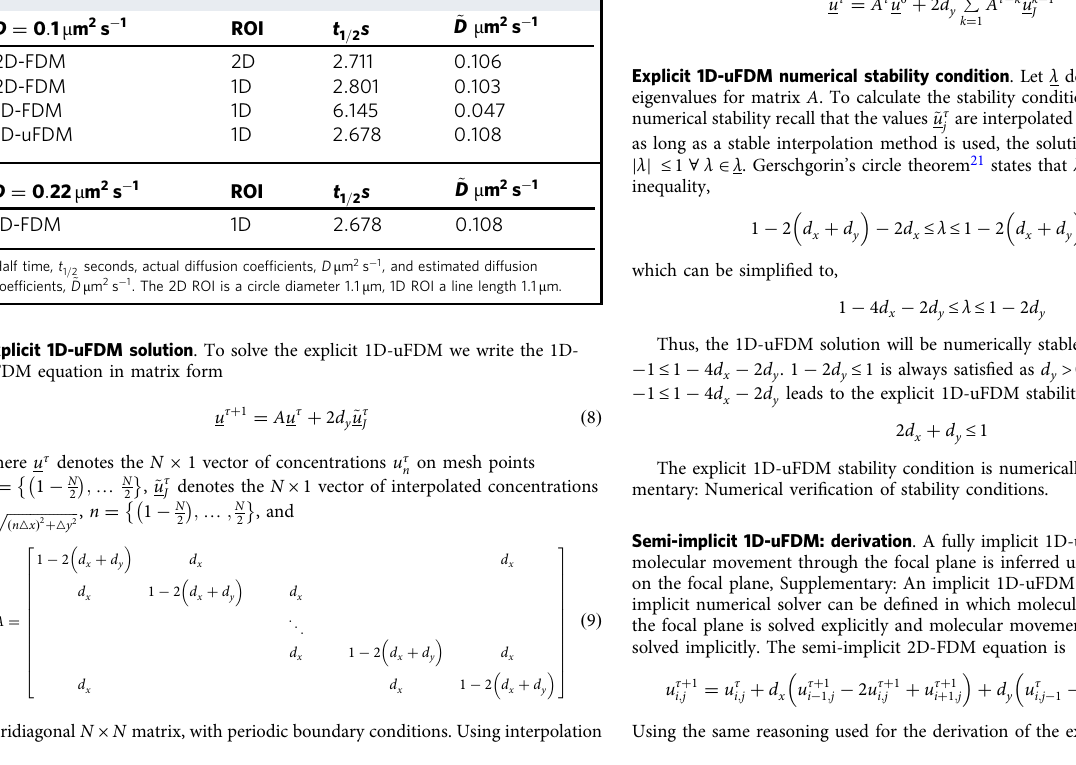
Table 1 Results of FRAP analysis on the 1D and 2D